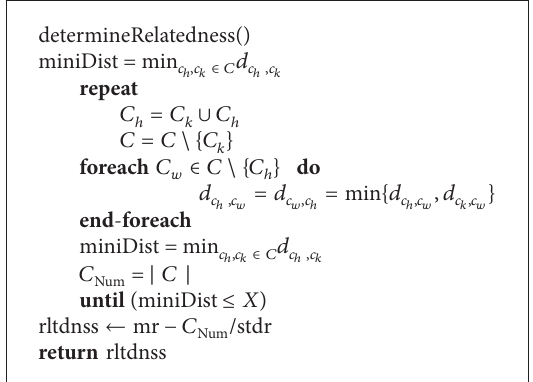
Pseudocode 3: The pseudocode of determineRelatedness